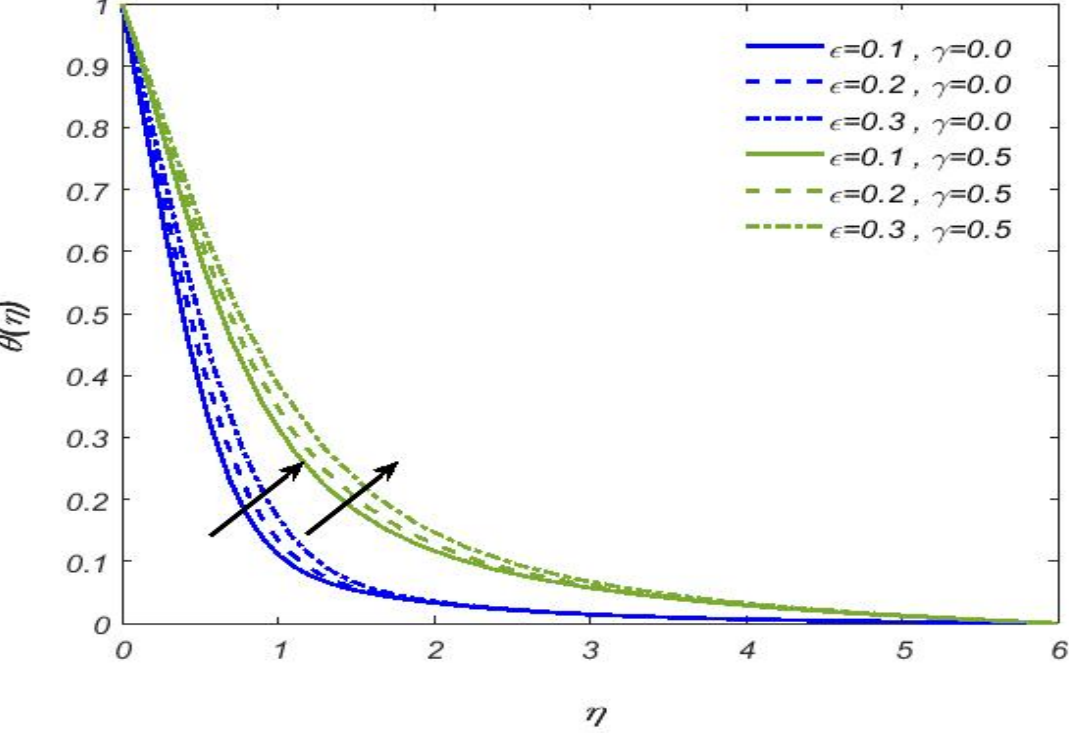
. Figure 9. Effect of ε on θ